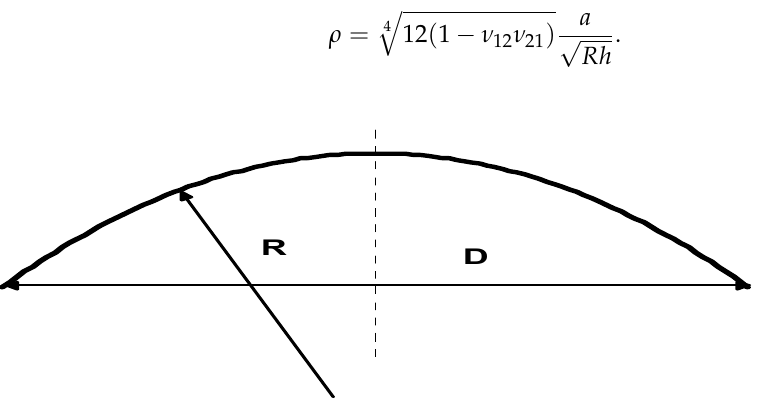
Figure 11. Cross-section and geometry of spherical shells.